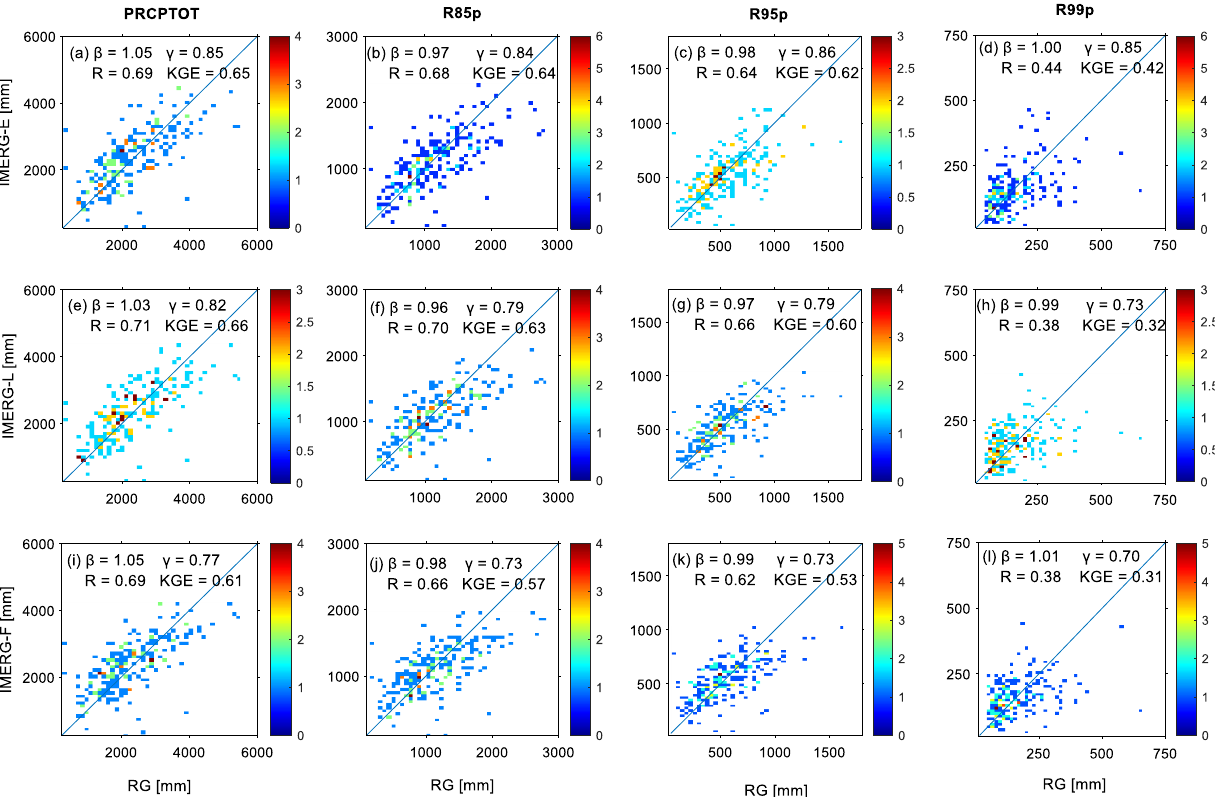
Figure 4. Scatter plot of precipitation-amount-based indices from IMERG and RG observation, namely PRCPTOT ( a , e , i ), R85p ( b , f , j ), R95p ( c , g , k ), and R99p ( d , h , l ), for IMERG-E (top), L (middle) and F (bottom). The color indicates the number of data counts.